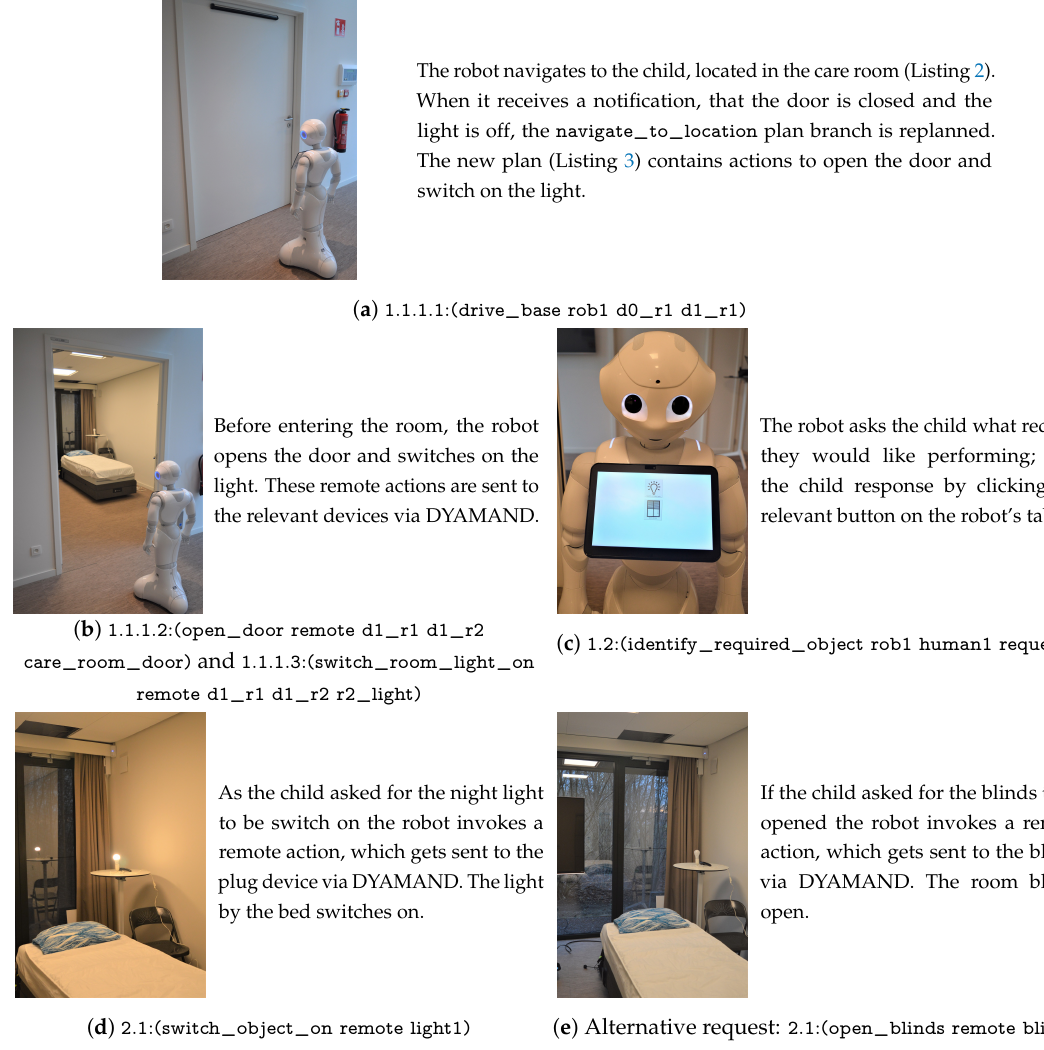
Figure 10. Real world tests. The full list of PDDL executed actions are given in Listings 3 and 4. Doorway has been shortened to d and room to